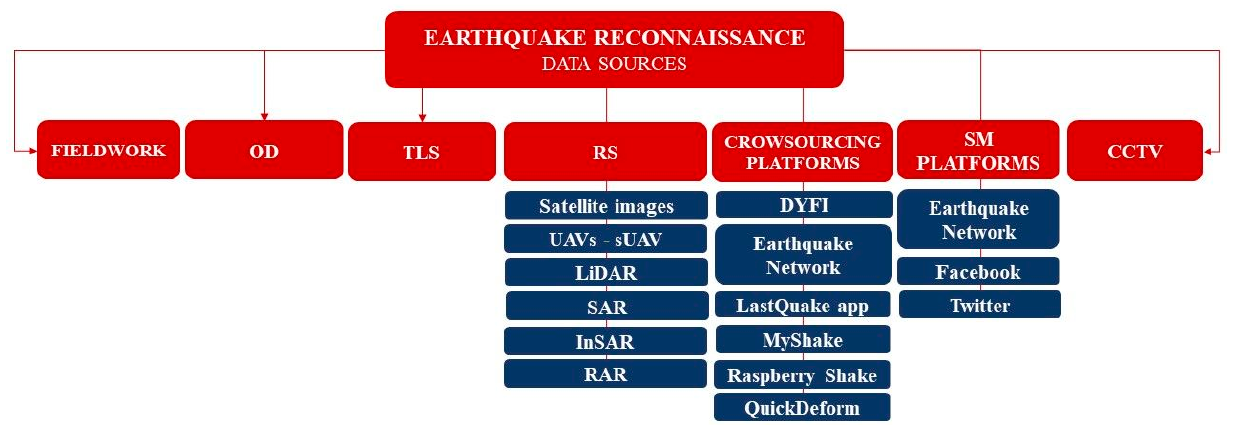
Figure 2. Earthquake reconnaissance data sources.